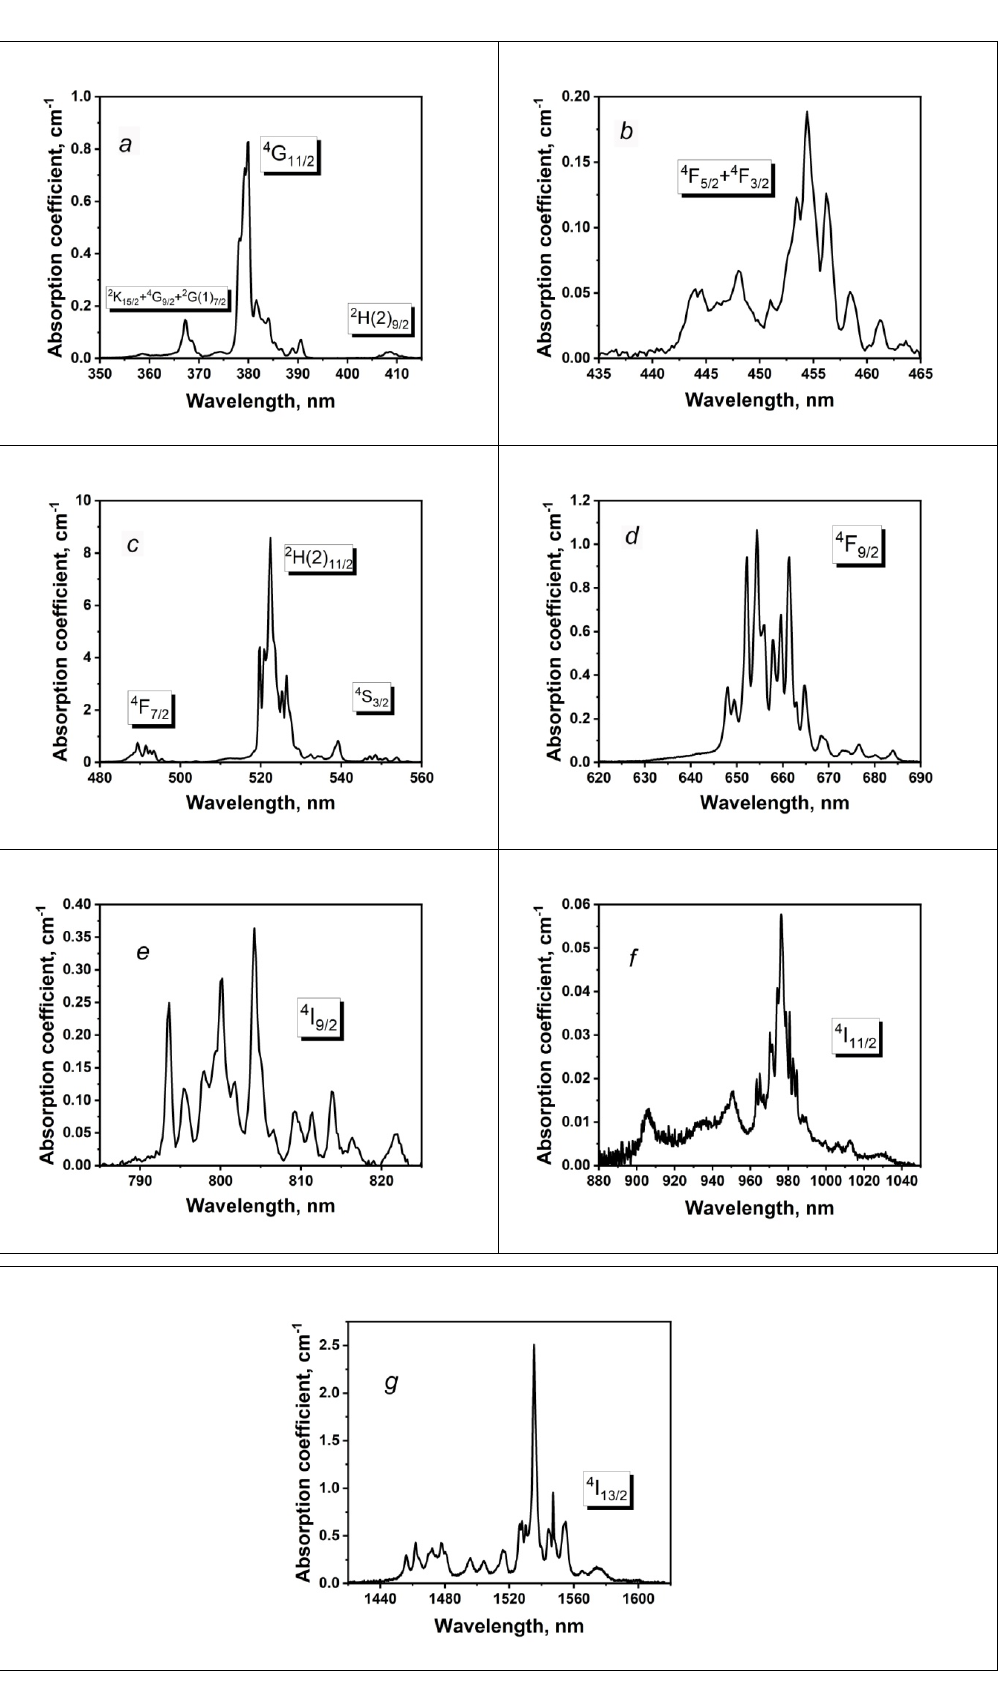
Figure 6. The absorption coefficients spectra of Er 3+ :Y 2 O 3 optical ceramics: ( a ) in the spectral range of 350–410 nm; ( b ) in the spectral range of 435–465 nm; ( c ) in the spectral range of 480–560 nm; ( d ) in the spectral range of 620–690 nm; ( e ) in the spectral range of 780–830 nm; ( f ) in the spectral range of 880–1050 nm; ( g ) in the spectral range of 1430–1650 nm . The spectral lines in the regions of 350–370 nm (Figure 6 a ) and 440–465 nm (Figure 6b) corresponding to the transitions 4 I 15/2 → 2 K 15/2 , 4 I 15/2 → 4 G 9/2 , 4 I 15/2 → 2 G(1) 7/2 and transi- tions 4 I 15/2 → 4 F 5/2 , 4 I 15/2 → 4 F 3/2 , respectively, overlap substantially, so they will be consid- ered in the J–O calculations as some effective spectral lines with overall oscillator strengths. The J–O theory considers electronic transitions between the energy levels of trivalent lanthanides, caused mainly by electric and magnetic dipoles, and allows for the calcula- tion of the radiative properties of media doped with rare-earth ions. The fundamentals and numerous applications have been widely discussed in the literature—e.g., see Refs. [23–25]. The selection rules for the magnetic-dipole transition in the Russell–Saunders ap- proximation are as follows [26]: ′ = , + , −